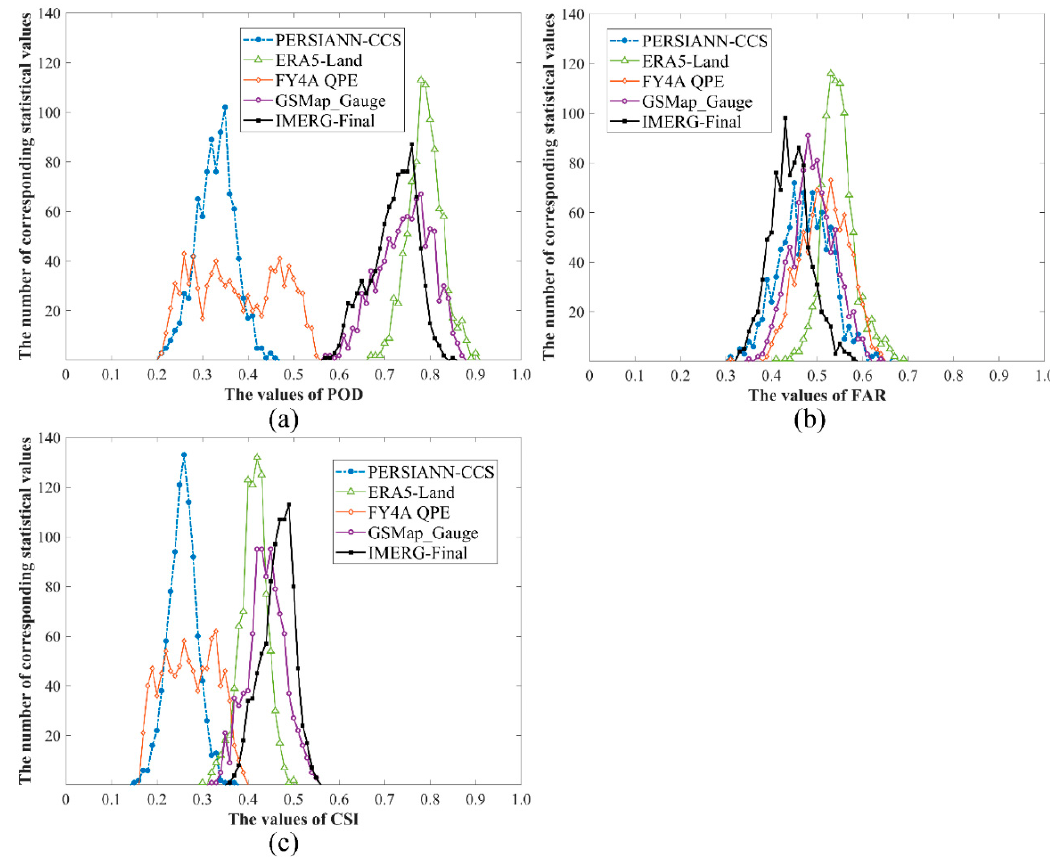
Figure 6. The numerical distributions of ( a ) POD, ( b ) FAR, and ( c ) CSI for the five precipitation products over the Zhejiang province in summer, from June to August 2019.